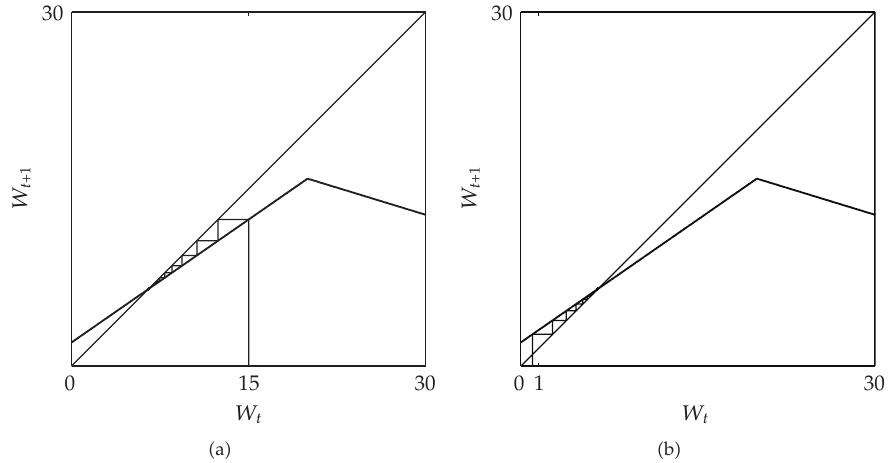
Figure 2: Koenigs Lemerary staircase diagram for two di ff erent initial conditions: in (cid:3) a (cid:4) , W 0 (cid:7) 15 ∈ (cid:3) W (cid:4) ,W M (cid:4) while in (cid:3) b (cid:4) , W 0 (cid:7) 1 < W (cid:4) 1